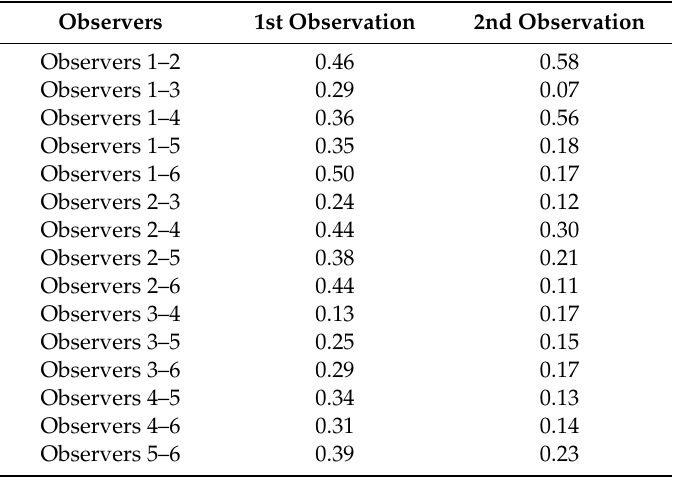
Table 10. Inter-observer reliability, Kappa